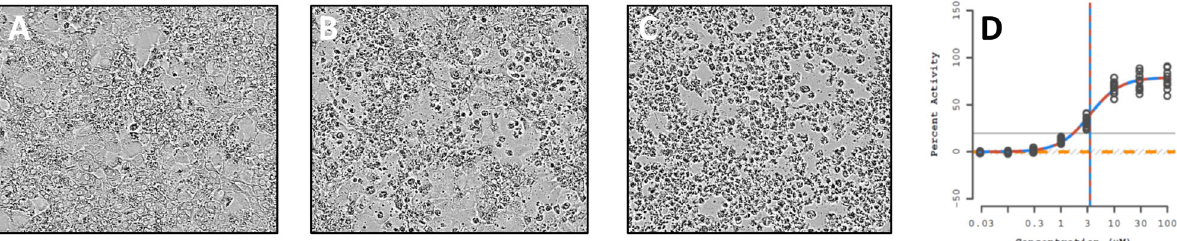
Fig. 2 Visual assessment of a fl atoxin B1 (AFL) cytotoxicity in cells. Images of cells treated for 48 h with ( A ) 0.5% DMSO vehicle control, ( B ) 3.16 μ M AFL (~EC10) or ( C ) 100 μ M AFL. ( D ) LDH assay dose-response curve for AFL treated